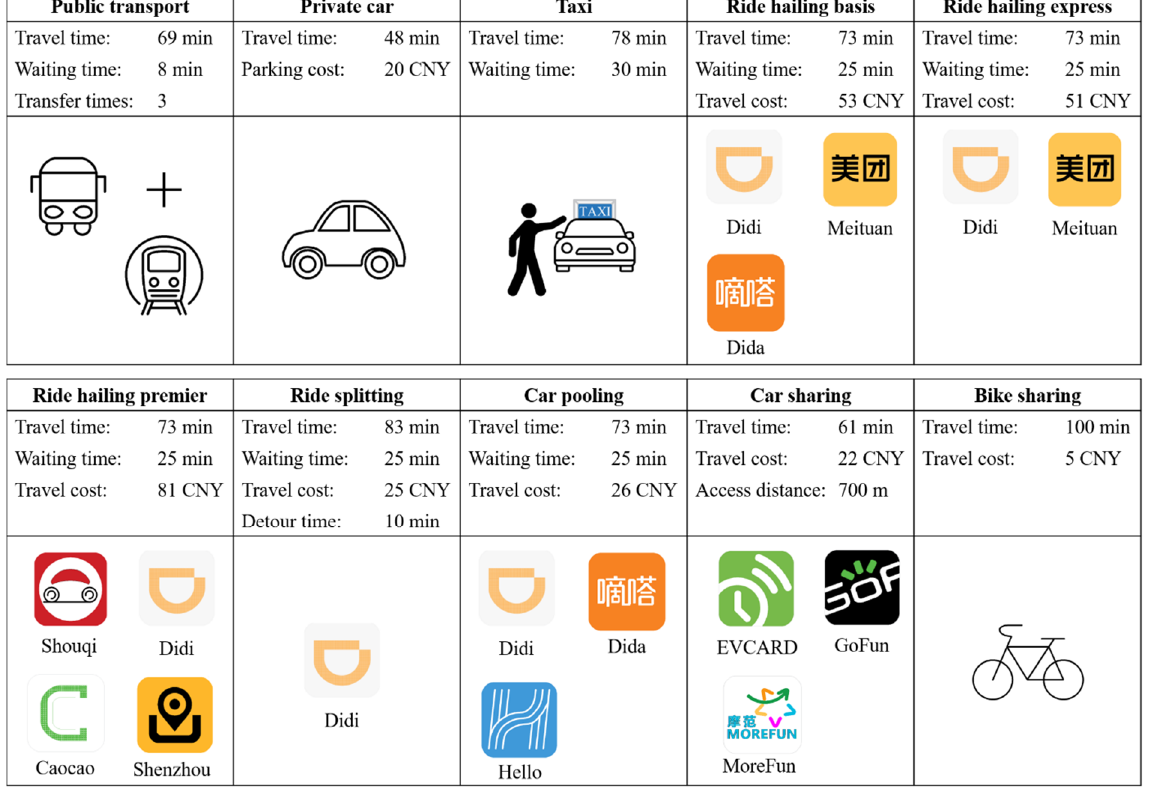
Figure 2. An example of the SP experiment (under the scenario of leisure trip, evening peak, and 20